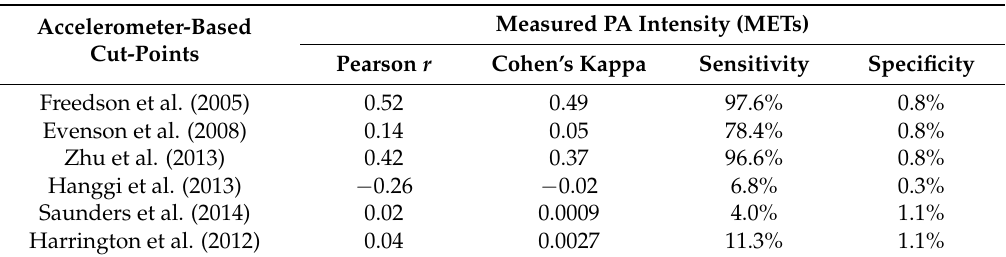
Table 5. Correlation and Kappa Coefficients among Measured vs. Estimated PA